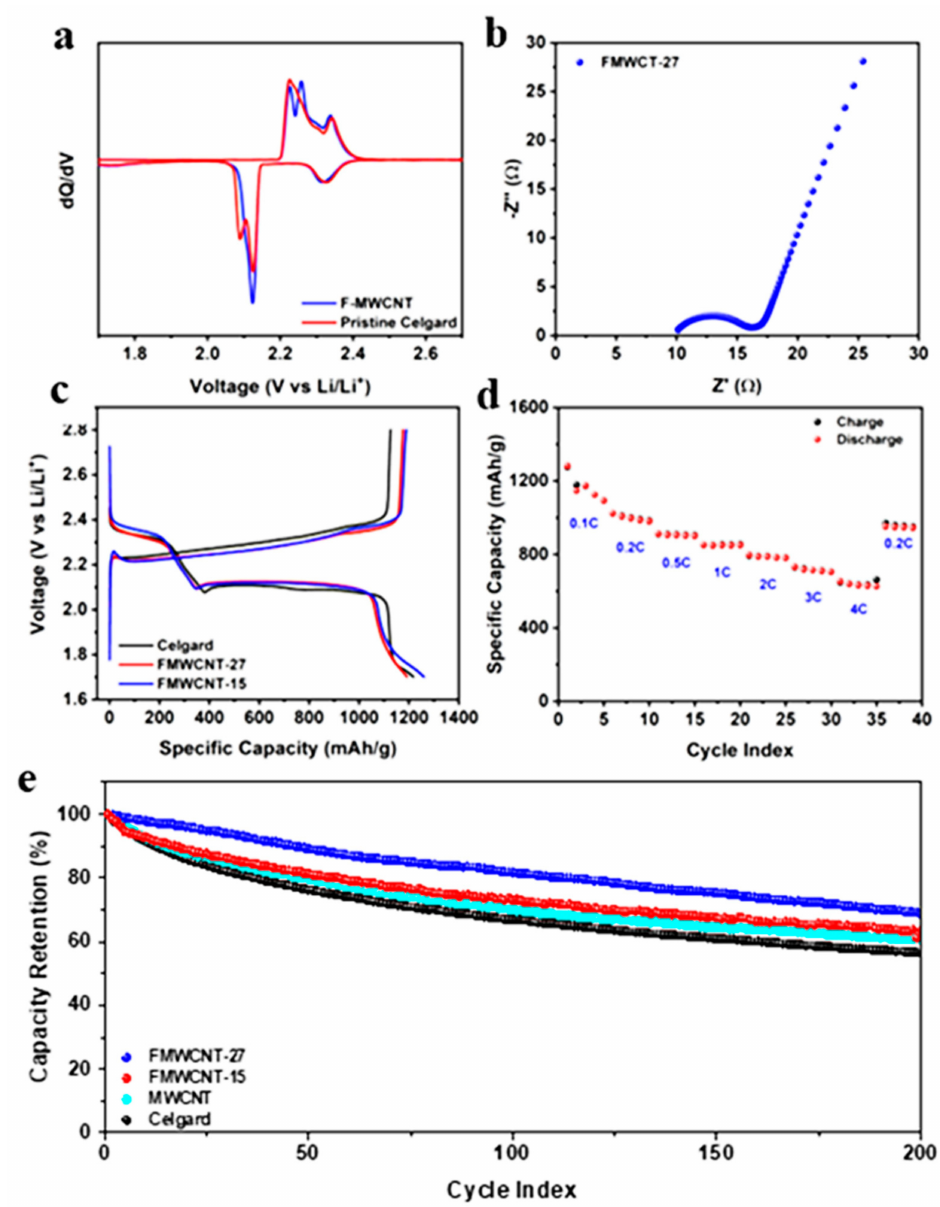
Figure 3. ( a ) Differential capacity plots for FMWCNT-27 and pristine Celgard and ( b ) electrochemical impedance spectroscopy data of the FWCNT-27 coated separator. ( c ) First cycle charge–discharge profiles for cells with pristine Celgard separator (black), FWCNT-15 (blue), FMWCNT-27 (red) coated separator at 0.1 C, and ( d ) rate performance charts for FMWCNT-27 from 0.1 C to 4 C. ( e ) Capacity retention for cells with pristine Celgard (black), FWCNT-15 (red) and FMWCNT-27 (blue) coated separator tested at 1